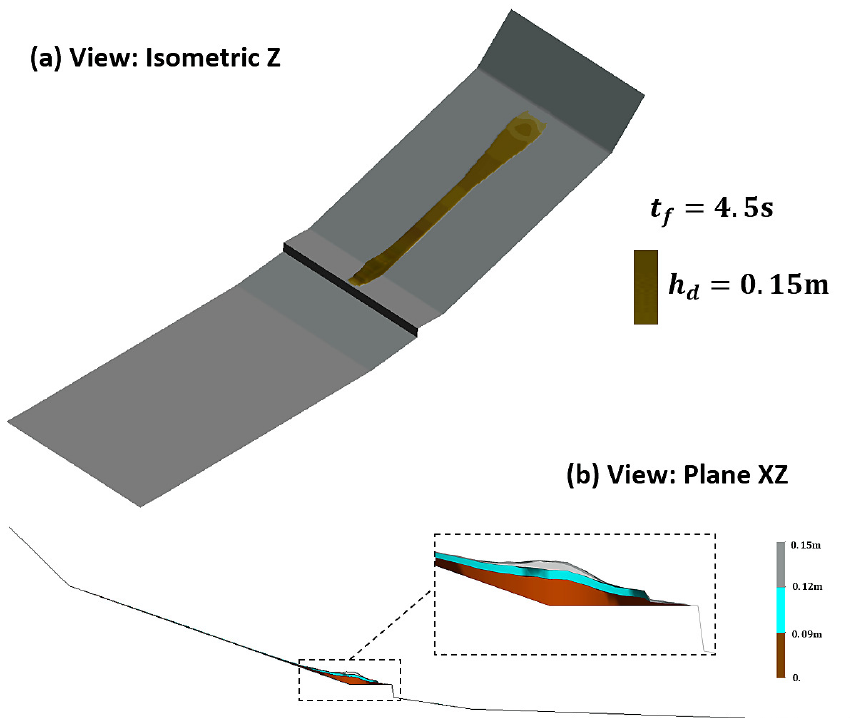
Figure 9. The numerical results of deposition thickness of flume test, containing high permeability soil, in two different views: ( a ) isometric Z and ( b ) plane